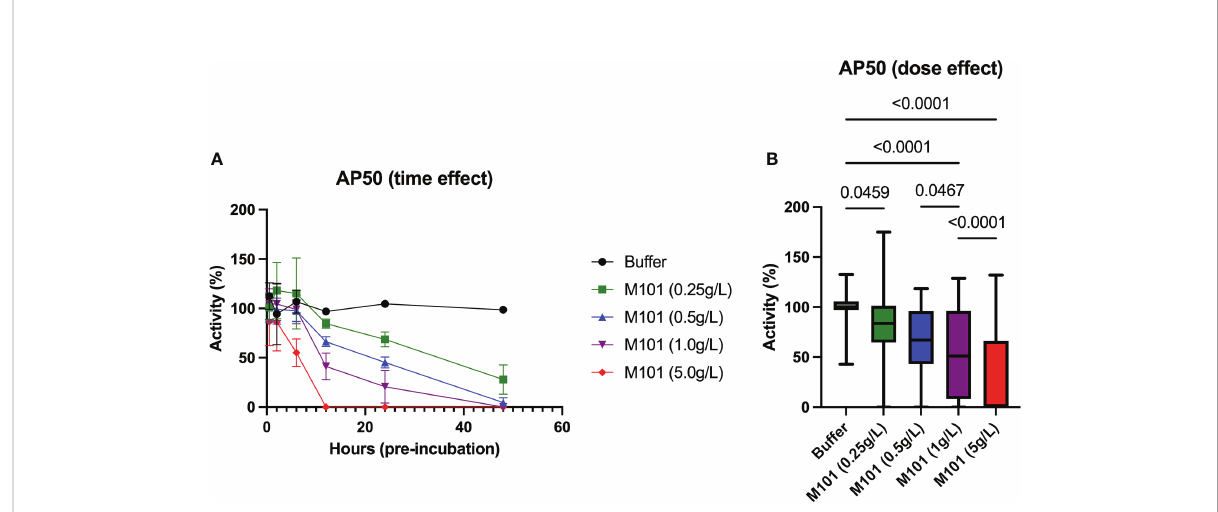
FIGURE 6 Dose and time-effect of M101 on the alternative complement pathway (AP50/AH50). Whole uncoagulated blood from 5-6 healthy controls were pre-incubated with an increasing amount of M101 (buffer, 0.25 g/L, 0.5 g/L, 1 g/L and 5 g/L) during 30 min, 2h, 6h, 12h, 24h and 48h before being centrifugated and serum frozen (-80°C). AP50 activity was then evaluated by hemolytic activity from sera using rabbit blood cells. (A) M101 pre-incubation time effect. (B) M101 dose effect, for each concentration all time points are indicated, and results are expressed as box plots of interquartile range. P values are indicated when signi fi cant